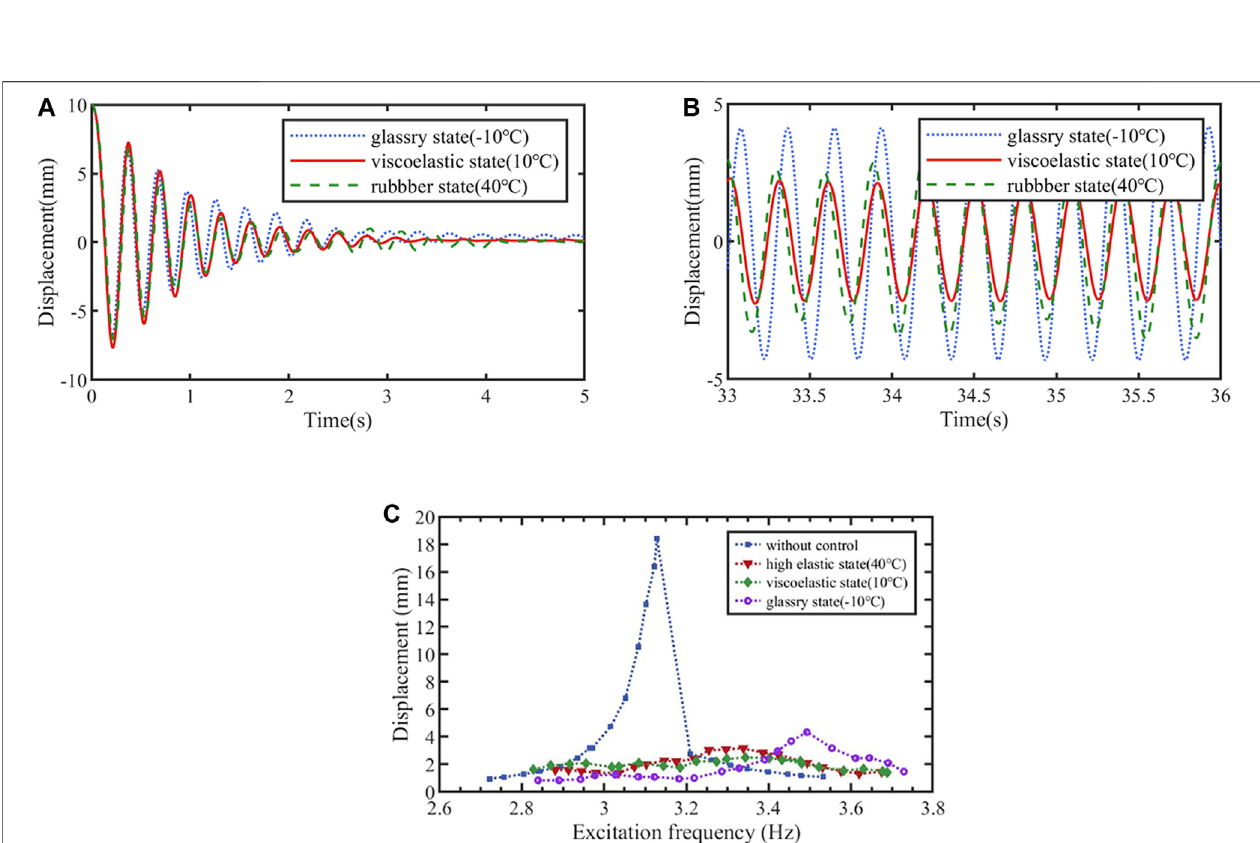
FIGURE 10 | Displacement response of the portal frame at different state: (A) Free vibration in time domain; (B) Resonant vibration in time domain; (C) Forced vibration in the frequency domain.